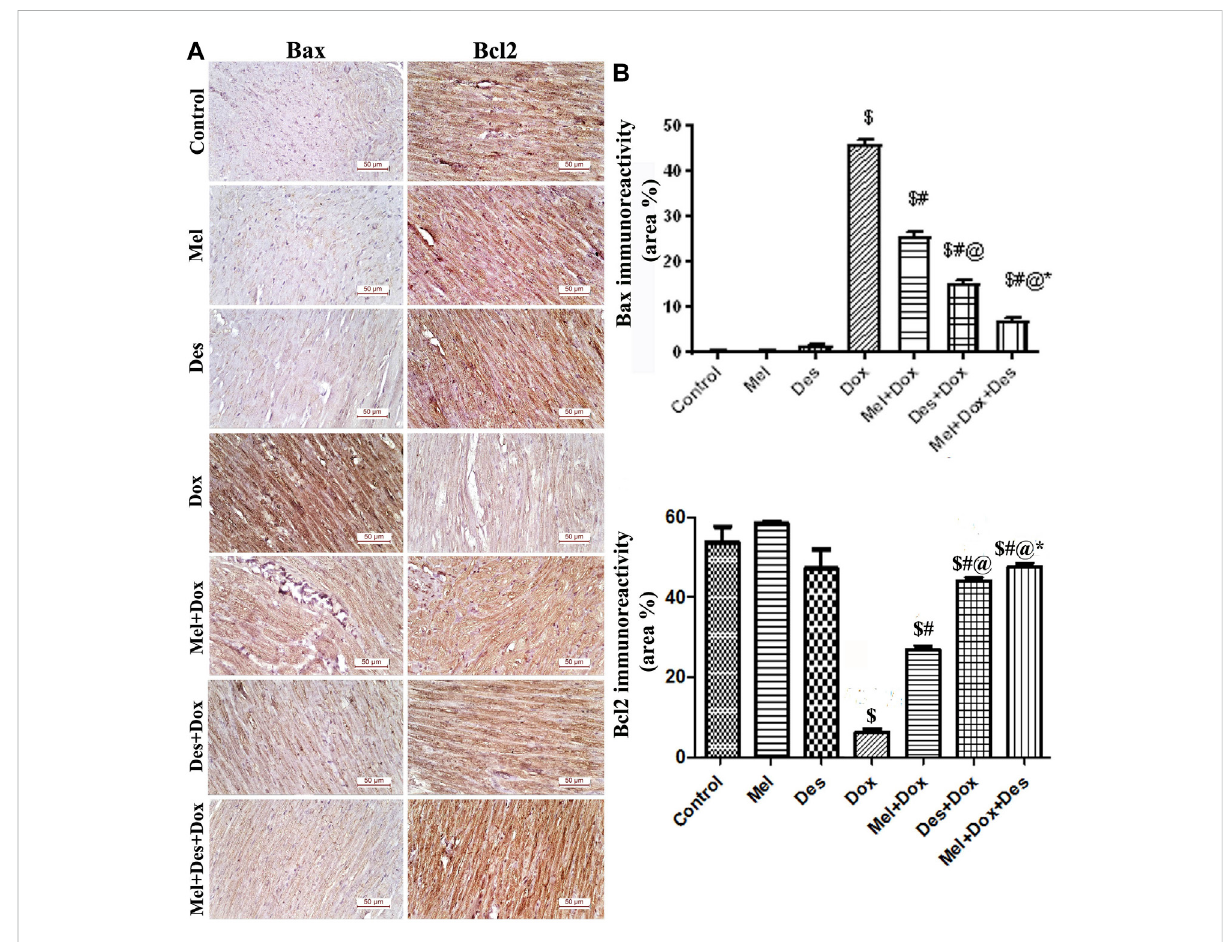
FIGURE 5 (A) Representative fi gures of Bax/Bcl2 immunoreactivity in the myocardium (scale bar 50 µm). (B) Area percentage of Bax/Bcl2 immunohistochemical expressioninthedifferentstudygroups,$:signi fi cant versus control,#:signi fi cant versus Dox, @:signi fi cantversusMel-Dox, *: signi fi cant versus Des-Dox at p < 0.05, (n = 10) using ANOVA, Tukey post-hoc test for pairwise comparison. Mel: melatonin, Des: Deferoxamine, Dox: